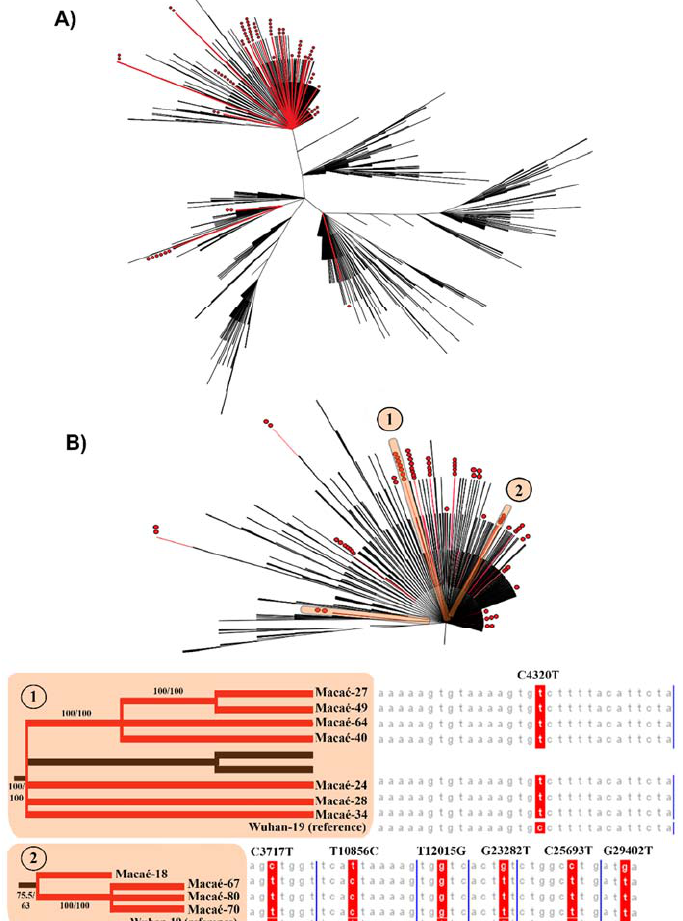
Figure 1. Phylogenomic analyses of SARS-CoV-2 variants show patterns of variant lineage insertion and local transmission in Maca é . ( A ) Phylogenomic relationship of 76 SARS-CoV-2 samples from Macaé (red branches) and from other regions of Brazil (black branches). Each red dot represents a sequenced sample generated in this study. ( B ) Phylogenomic trees from two Maca é clusters formed from local transmissions and their distinguished profile of mutations compared with that of the Wuhan-19 as the reference sequence on multiple sequences alignments. The branch support values are displayed above the respective branches and are represented as SH-aLRT/Bootstrap support